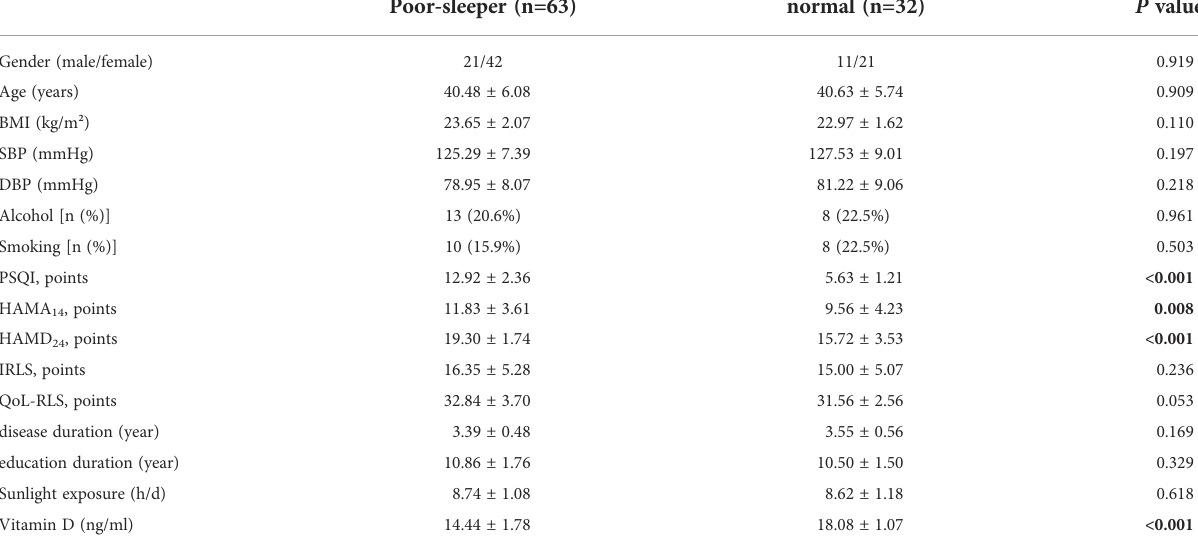
TABLE 1 Demographic data and results of biochemical